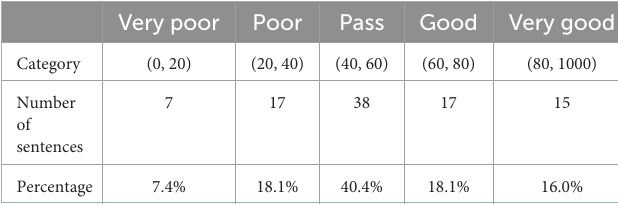
TABLE 1 Score distribution of fidelity in five levels of performance.